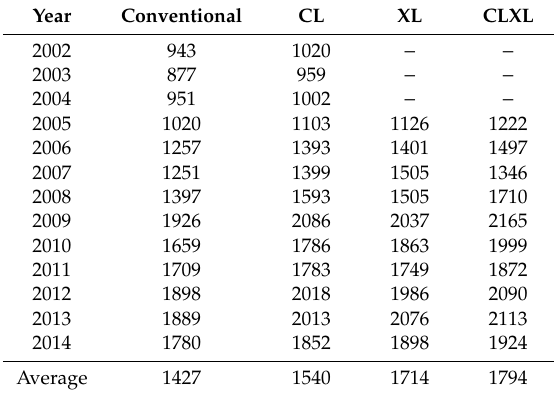
Table A2. Cost of production ($ ha − 1 ) for Conventional, Clearfield ® (CL), hybrid (XL), and Clearfield ® hybrid (CLXL) rice in the U.S. Mid-South: